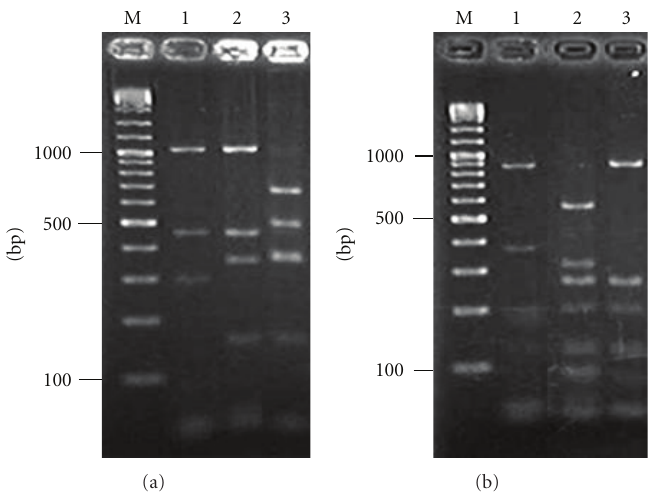
Figure 1: RFLP-PCR analyses of 18S rRNA genes of Phlebotomus (P.) argentipes and two Sergentomyia species. PCR amplification with Lu.18S 1S and Lu.18S AR primers was performed to amplify approximately 2,000 bp fragments of sand fly 18S rRNA gene. The PCR products were digested with Afa I (a) or Hin fI (b), and the digested samples were separated by electrophoresis in a 2% agarose gel to produce DNA fragments. Lane M; 100-basepair ladder, lane 1; P. argentipes , lane 2; Sergentomyia species A, and lane 3; Sergentomyia species B.